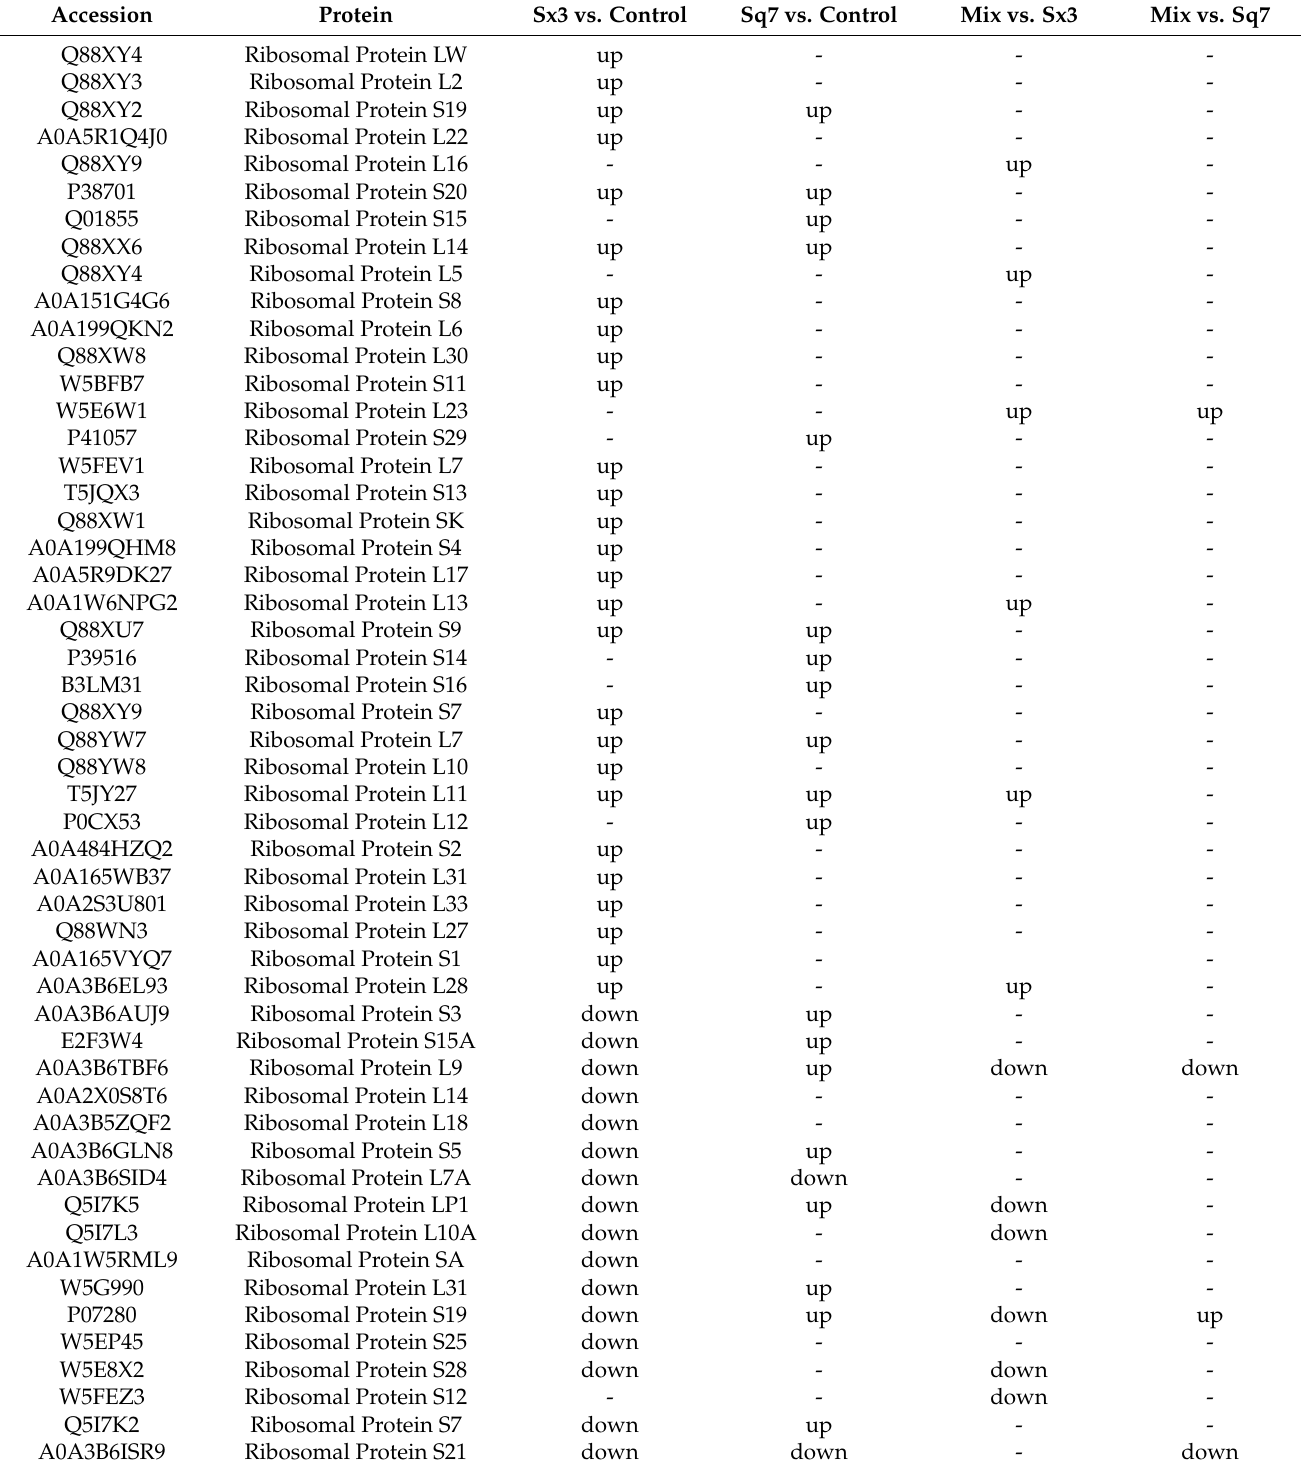
Table 1. Protein expression during the translation of different fermented sourdough